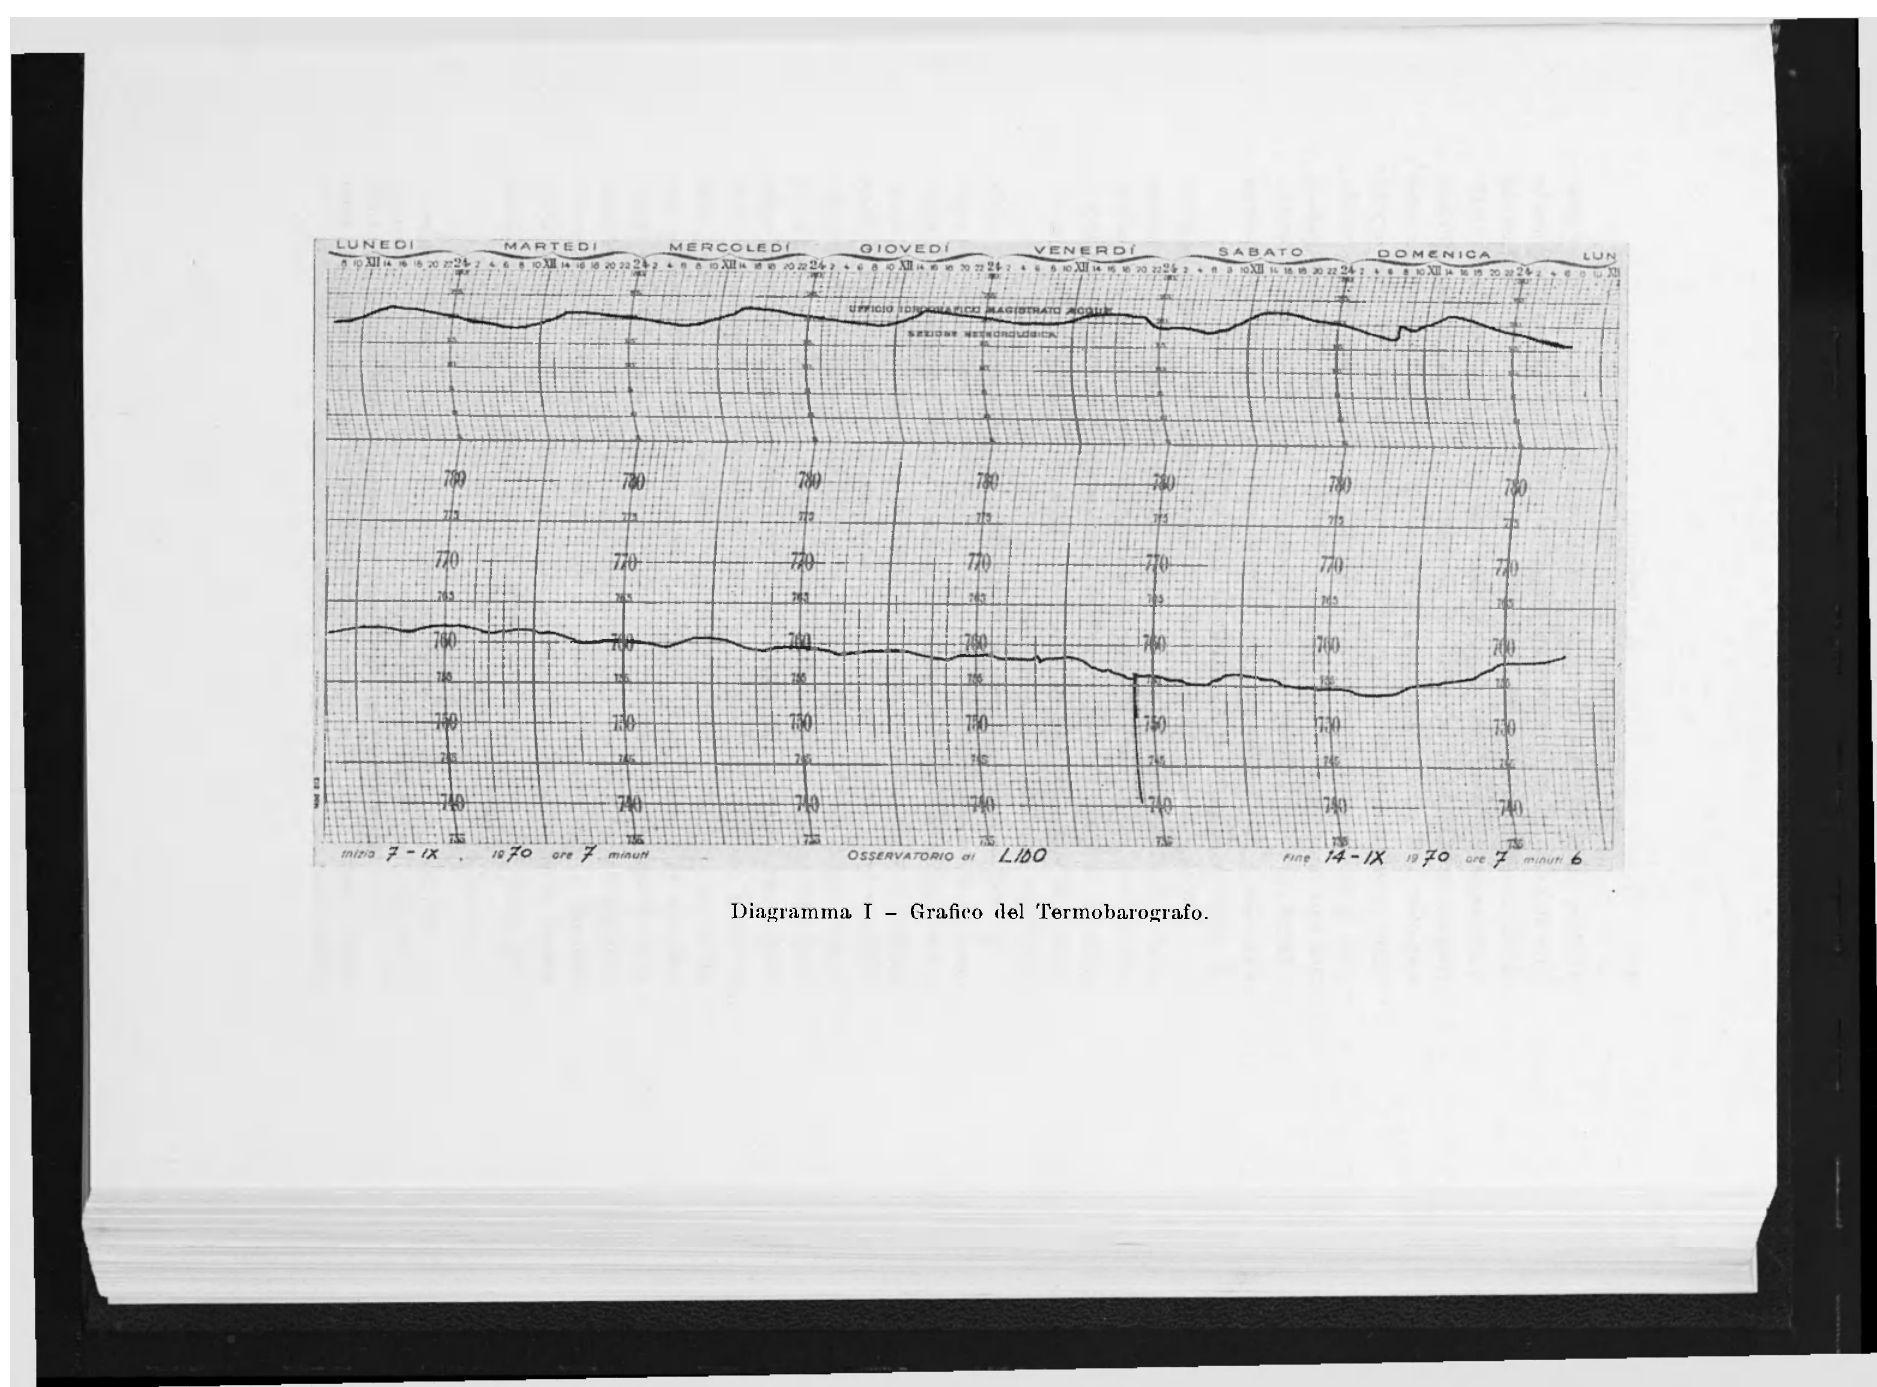
Diagramma I - Grafico (lei